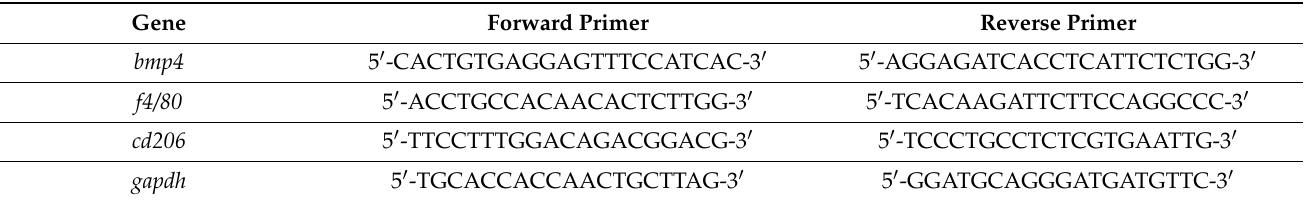
Table 1. Rat primer